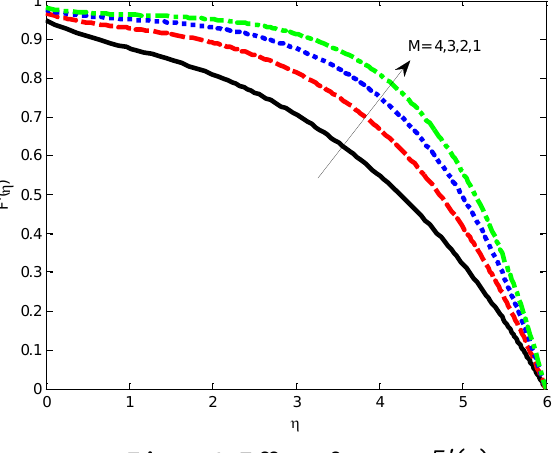
Figure 1. Effect of M on ( ) F  .